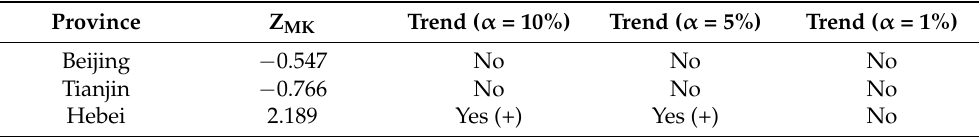
Figure 4. Virtual water footprint (VWF) and per capita VWF of the Beijing – Tianjin – Hebei (BTH) region. POP: population. Table 3. Mann–Kendall test results for virtual water footprint (VWF) during 2004–2017: α indicates the significance level; “Yes” or “No” indicates whether there is a monotonic trend (+: increasing trend with Z MK > 0; − : decreasing trend with Z MK <